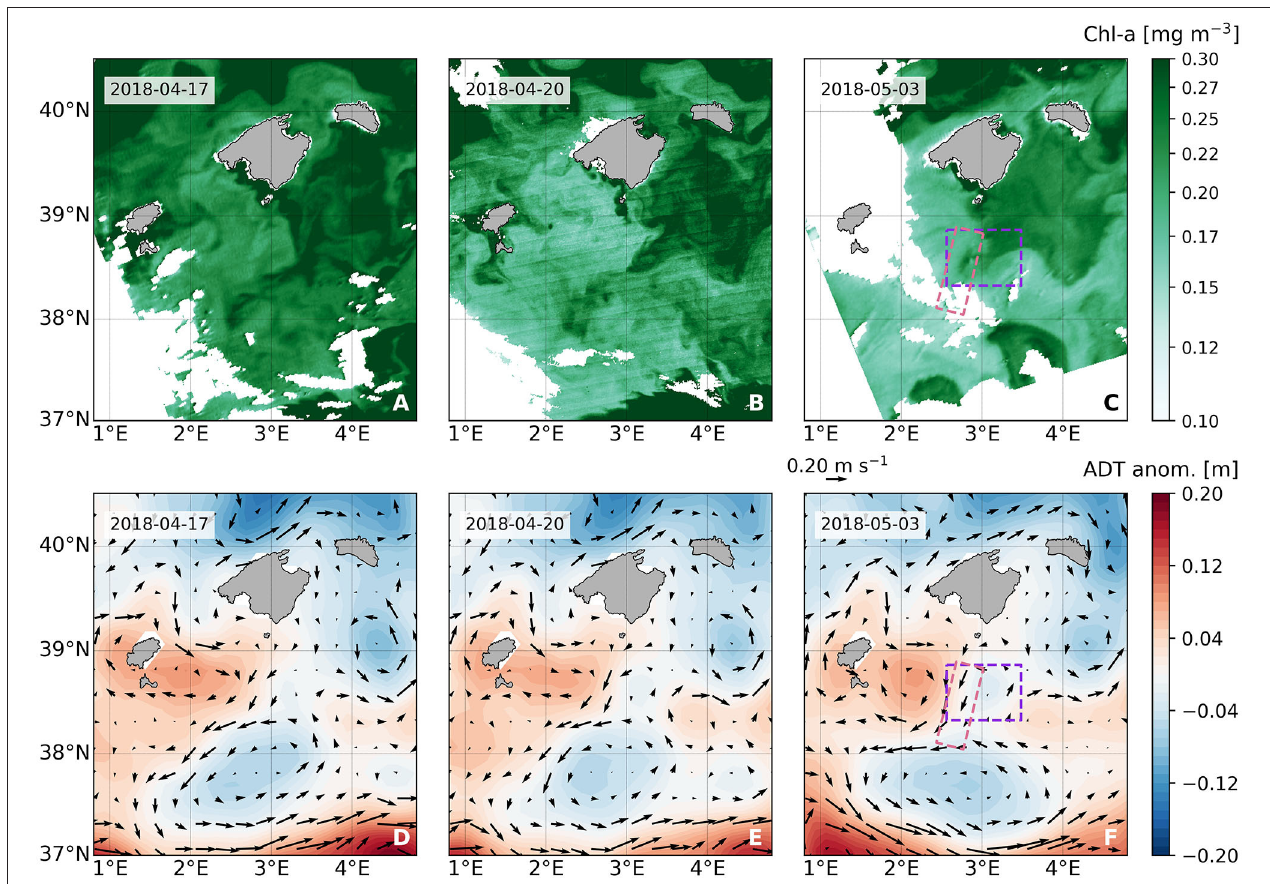
FIGURE 2 | (A–C) Ocean color images on different dates in the region of study. Data from MODIS were used on 17 April and 3 May 2018, while VIIRS data were used on 20 April 2018. (D–F) Absolute dynamic topography anomaly and altimetric geostrophic velocities on different dates in the region of study. For clarity, only one out of two current vectors are plotted. Purple and pink boxes in (C,F) delimit the regions sampled during Leg 1 and Leg 2 of the PRE-SWOT experiment,